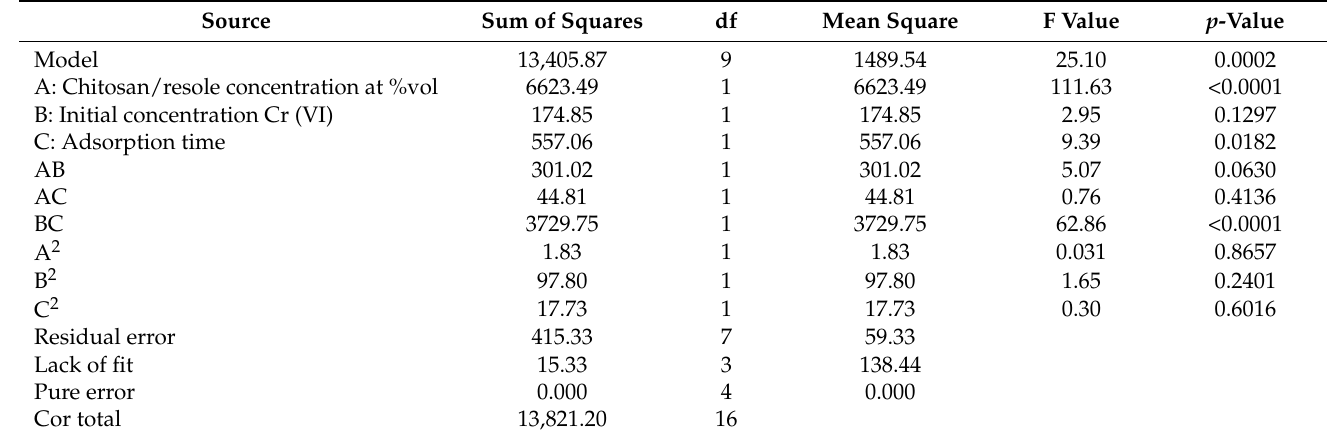
Table 3. Analysis of variance (ANOVA).